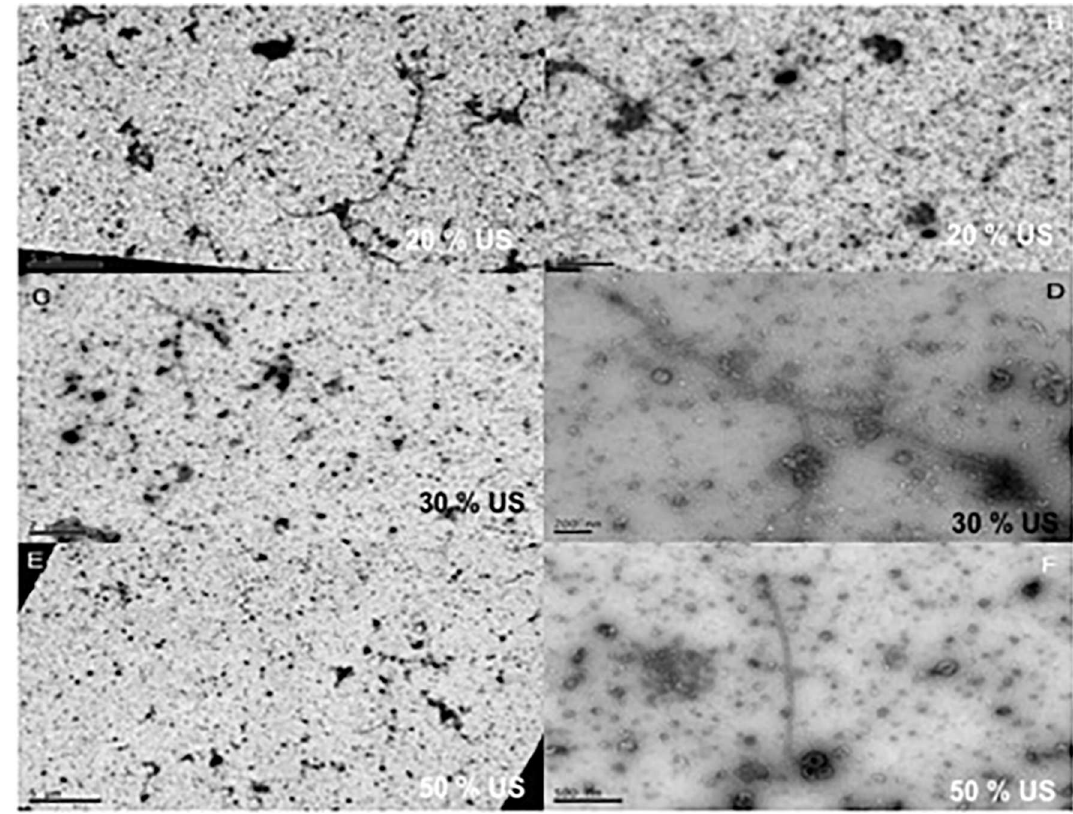
Fig 7. Transmission electron microscopy of human vitreous samples after pars plana vitrectomy with the hypersonic vitrector. (A and B) Vitrectomy at 20% ultrasound power showingfragmentation of the humanvitreous collagenfibrils. The levels of collagenfibril fragmentation increasedwith increasing ultrasoundpower. (C and D) at 30% ultrasoundpower. (E and F) at 50% ultrasound power.